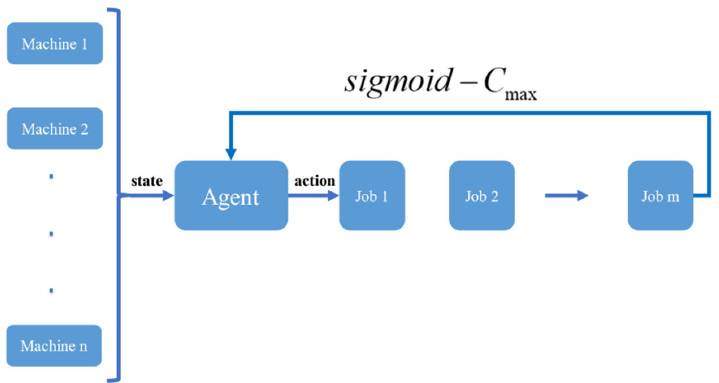
Figure 1. Algorithm flow chart.